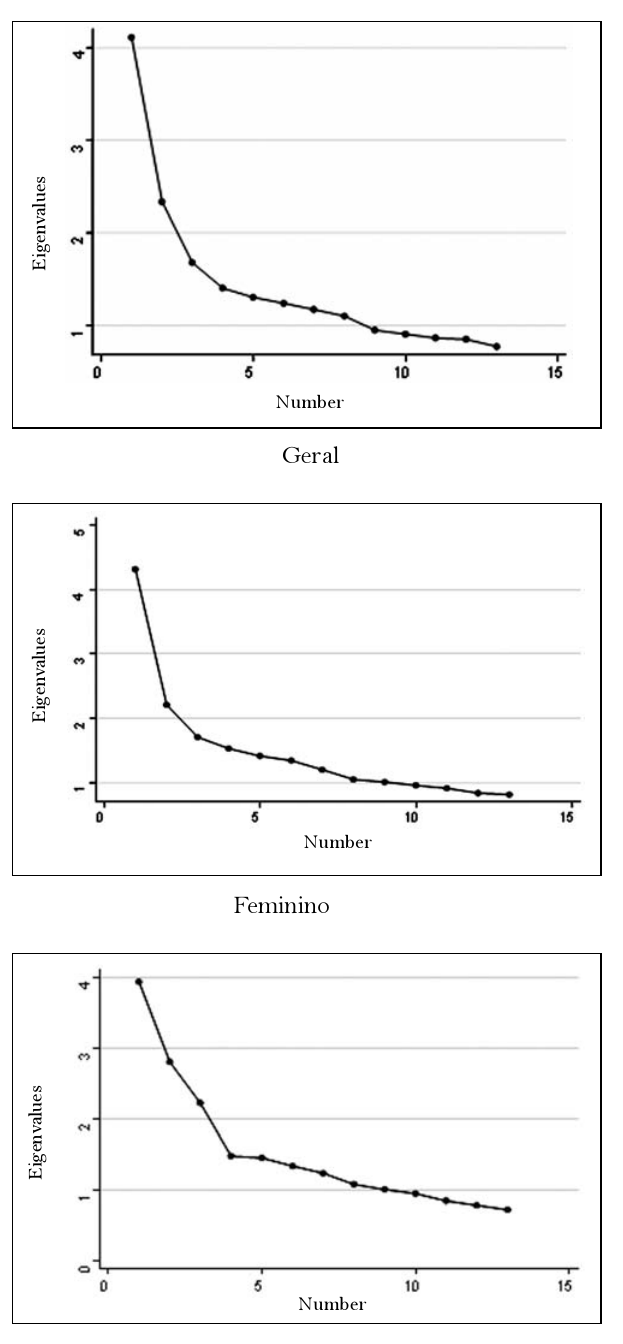
Figura 1 . Representação gráfica dos eigenvalues da análise fatorial, amostra geral e por sexo. A solução de quatro fatores, mais semelhante à versão original da escala, mostrou-se inadequada porque o quar- to fator ficaria constituído por apenas dois itens com con- teúdos teóricos diferentes, motivo pelo qual se optou pela solução de três fatores (Tabela 3). O primeiro fator com eigenvalue 4,11, contribuiu com 16% da variância, o segundo fator com eigenvalue 2,33, 9% da variância e o terceiro, com a eigenvalue 1,68 e 6% da variância, totalizando 31% da